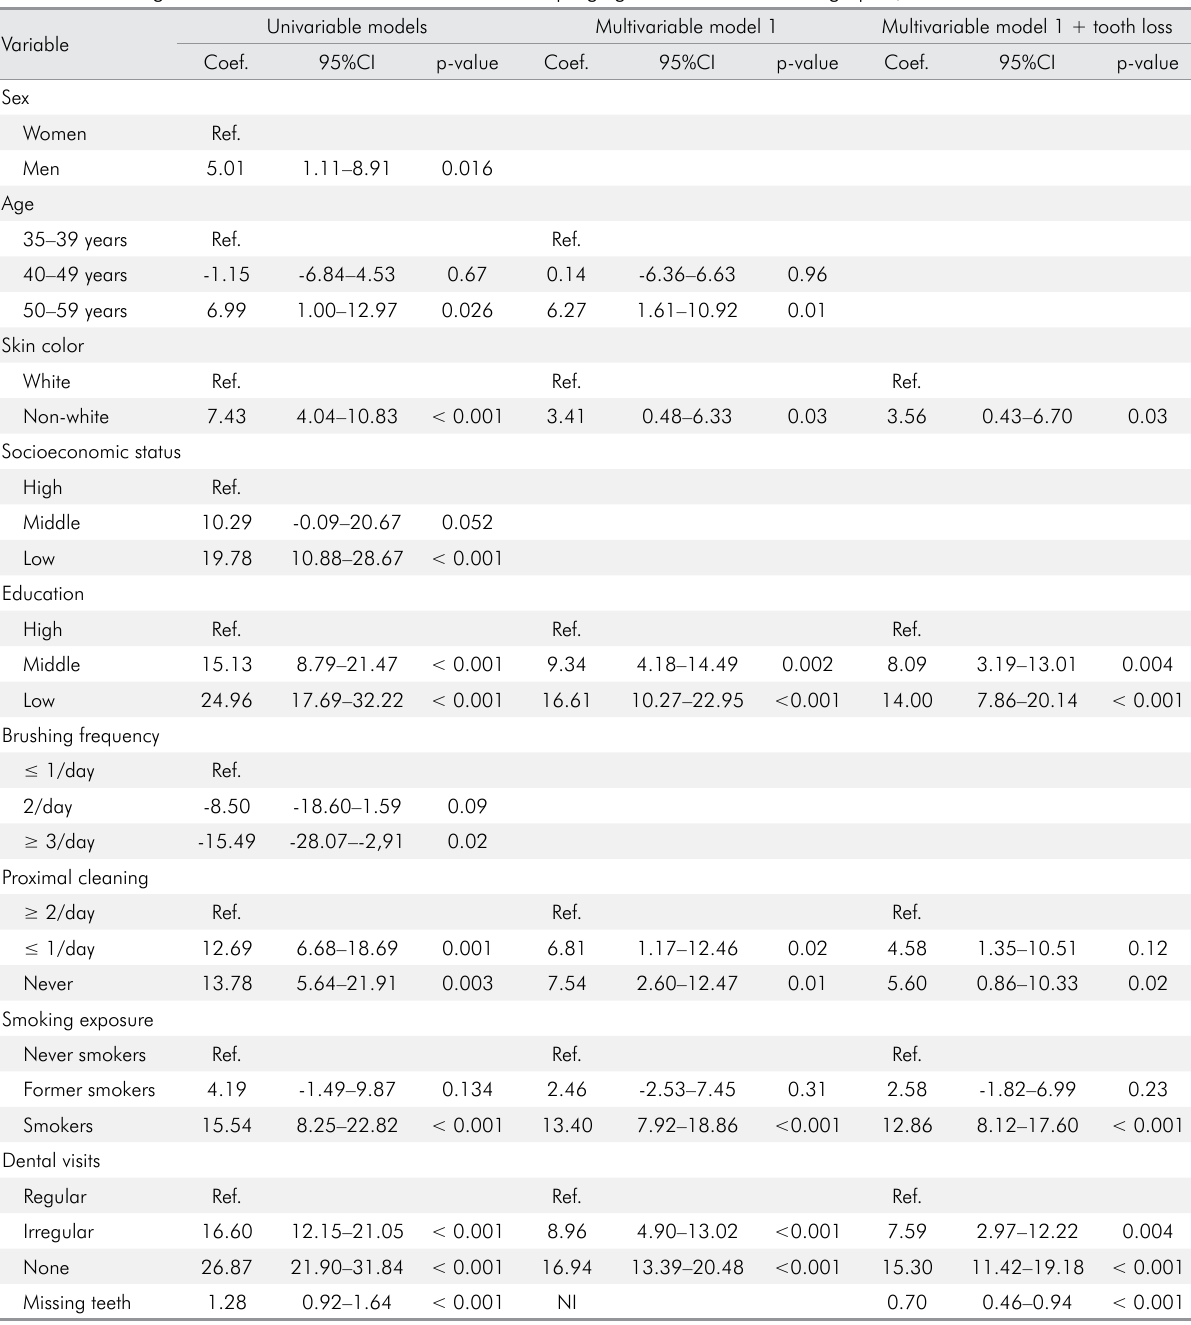
Table 3. Linear regression models of the association between supragingival calculus and demographic, behavioral and clinical